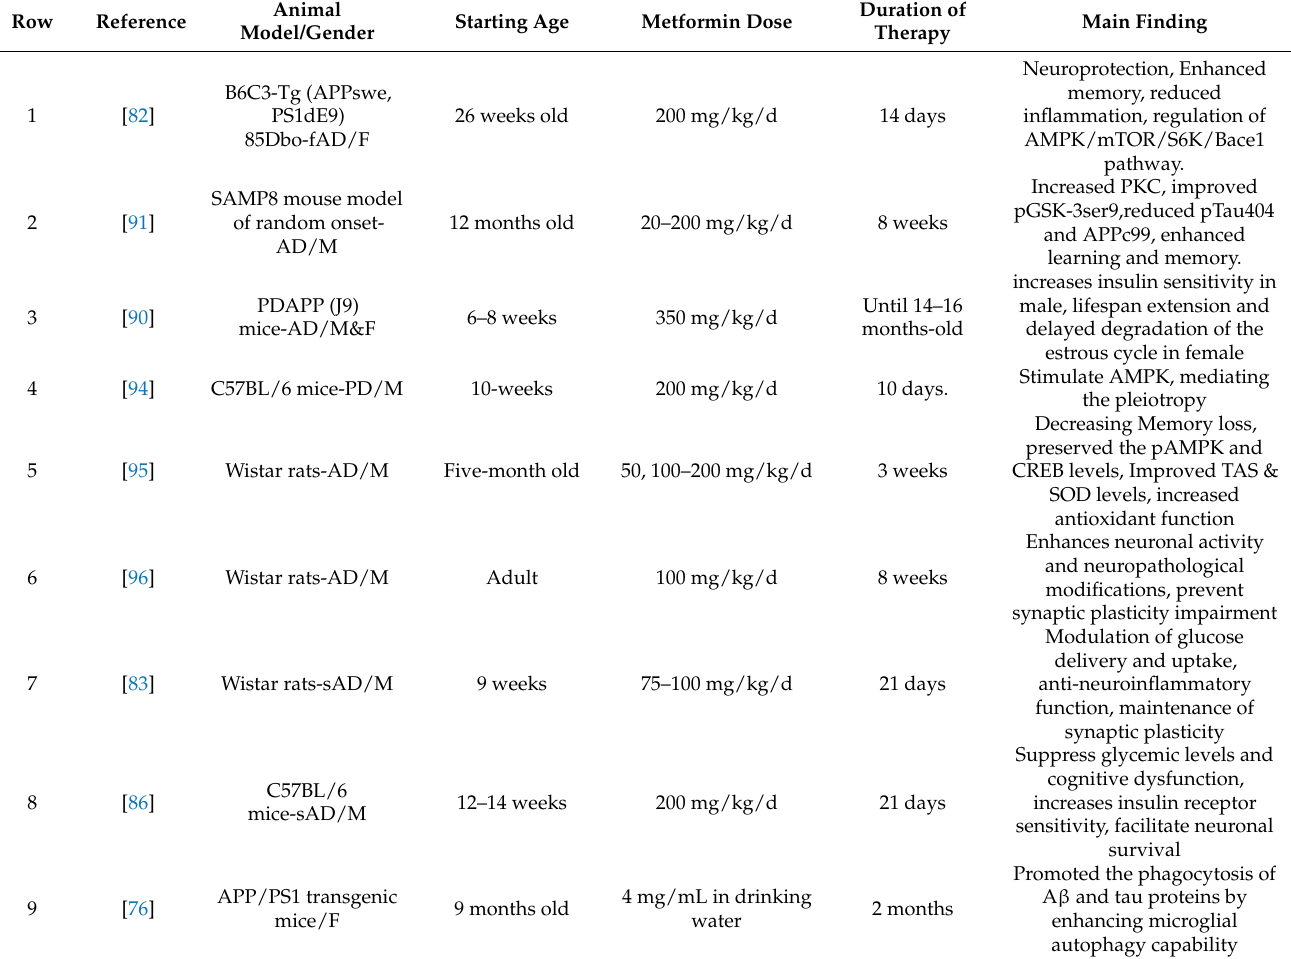
Table 1. Effect of different dose of metformin on treatment of preclinical Alzheimer’s